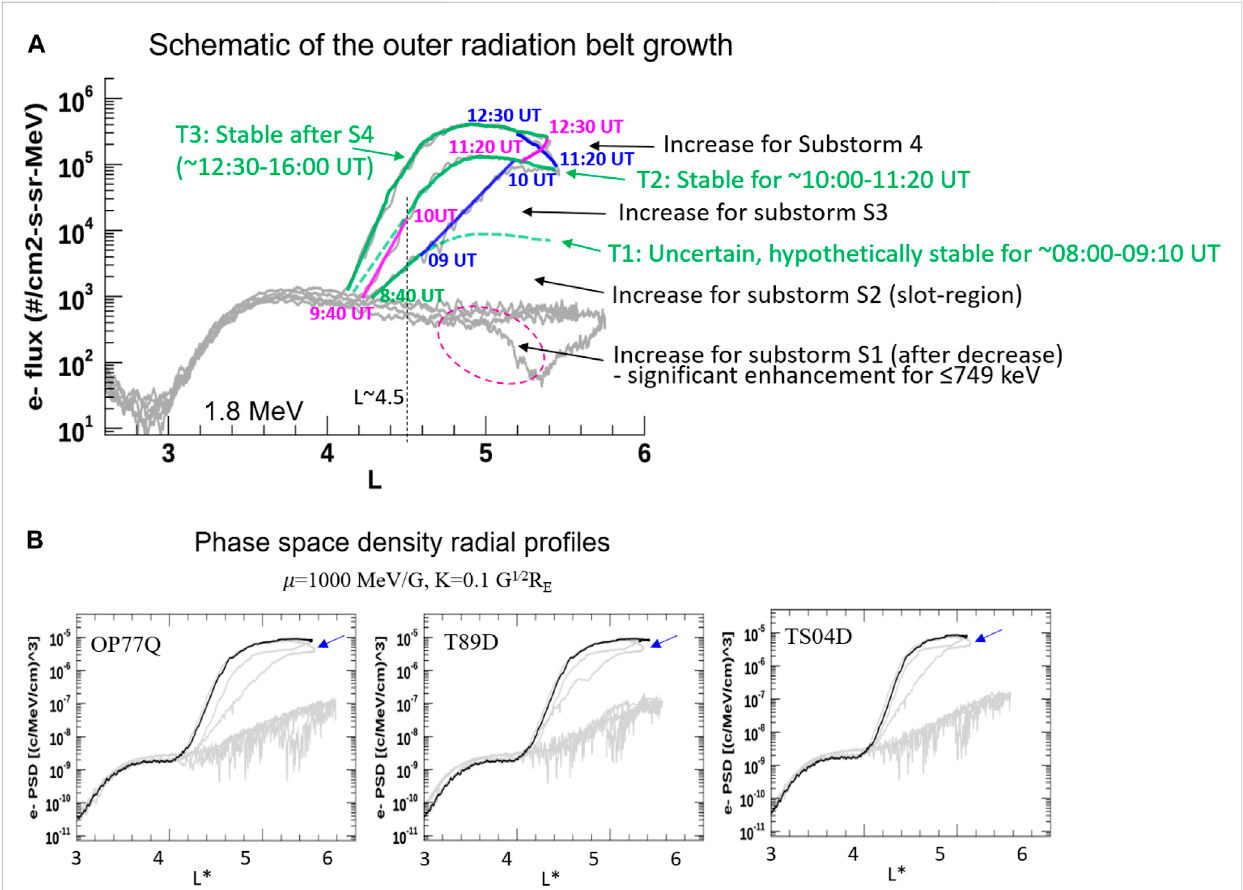
FIGURE 4 (A) Schematic of the growth of 1.8 MeV electron fl ux. Gray lines indicate the fl ux traces for 00-16 UT and green lines labeled T1 to T3 represent the purely spatial fl ux radial pro fi les that formed after substorms S2 and S4, respectively. Blue and pink line segments (marked with their starting and ending times) indicate temporal fl ux increases observed by P-A and P-B, respectively, for their corresponding substorms S3 and S4. (B) Quasi-stationary PSD radialpro fi leattheenhancementcompletionat12:30UT(blackuppermostcurve)computedfor μ =1000 MeV/GandK=0.1R E G 1 ∕ 2 usingmagnetic fi eld models, OP77Q (left panel), T89D (middle), TS04D (right). Gray lines indicate the PSD traces for earlier hours since 00